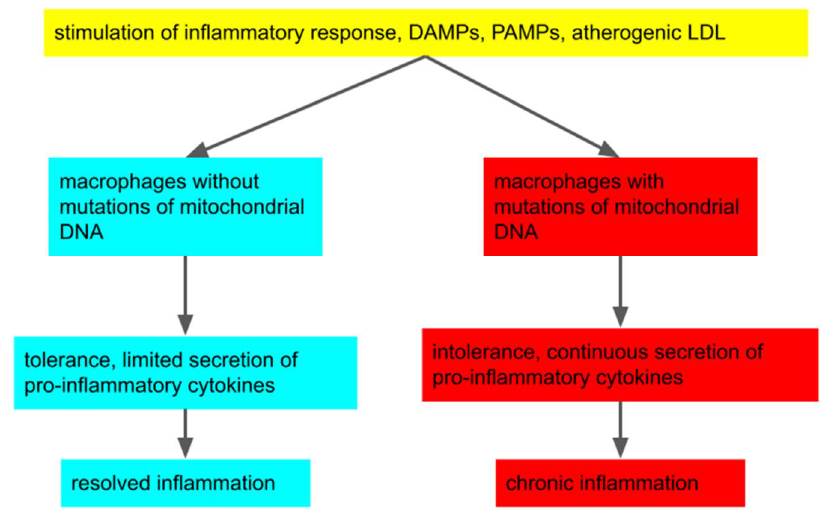
Figure 1. The hypothesis of the induction of chronic inflammation due to the presence of mutations of mitochondrial DNA in macrophages. Macrophages can recognize damage-associated molecular patterns (DAMPs), pathogen-associated molecular patterns (PAMPs), and atherogenic low-density lipoproteins (LDL), turn on a pro-inflammatory reaction, and secrete pro-inflammatory cytokines. In normal cases, a tolerance develops, and the macrophage stops releasing cytokines. However, in the presence of mitochondrial mutations, tolerance formation may be impaired, which could lead to continuous secretion of inflammatory cytokines and chronic inflammation development [3,4].